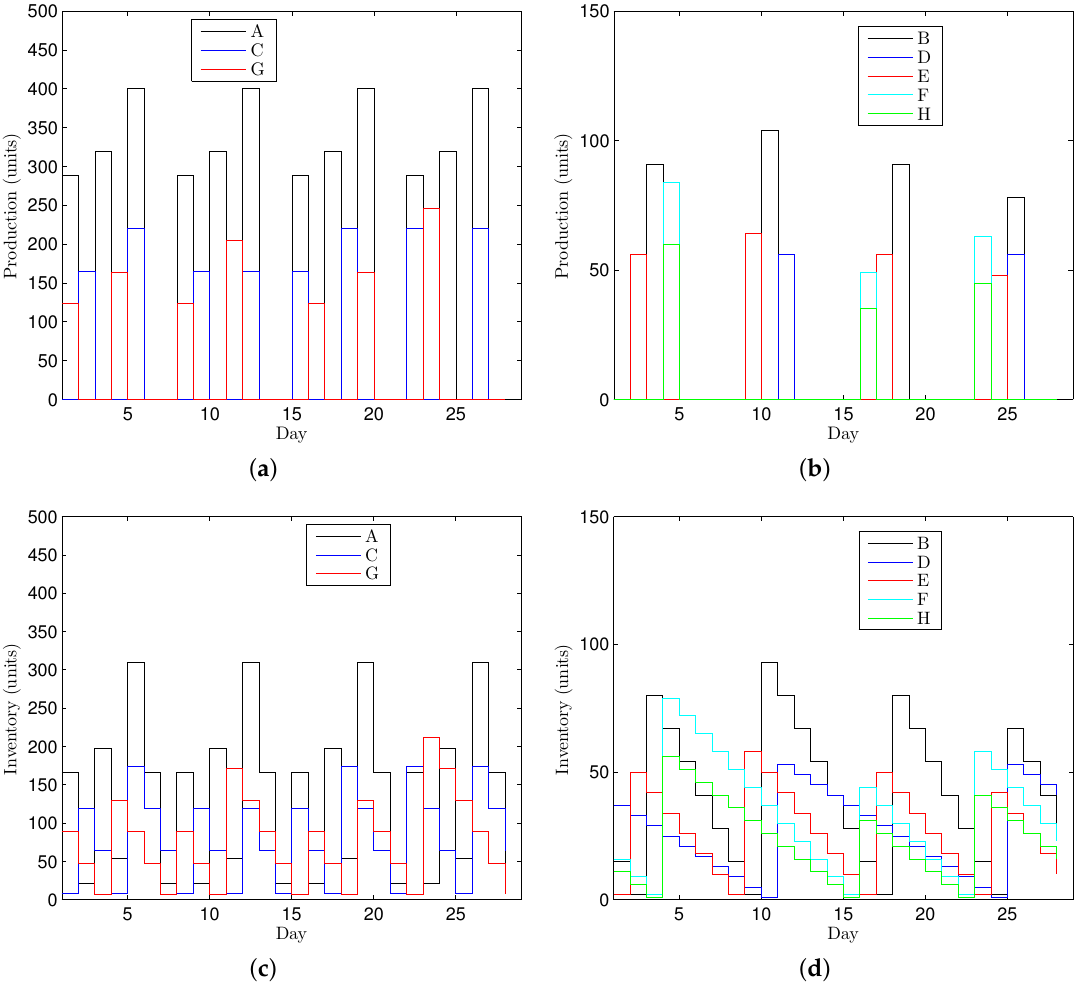
Figure 4. Optimal profiles for production and inventory levels with a deterministic consumption and without inventory control: ( a ) Production of A, C, G; ( b ) Production of B, D, E, F, H; ( c ) Inventory of A, C, G; ( d ) Inventory of B, D, E, F,